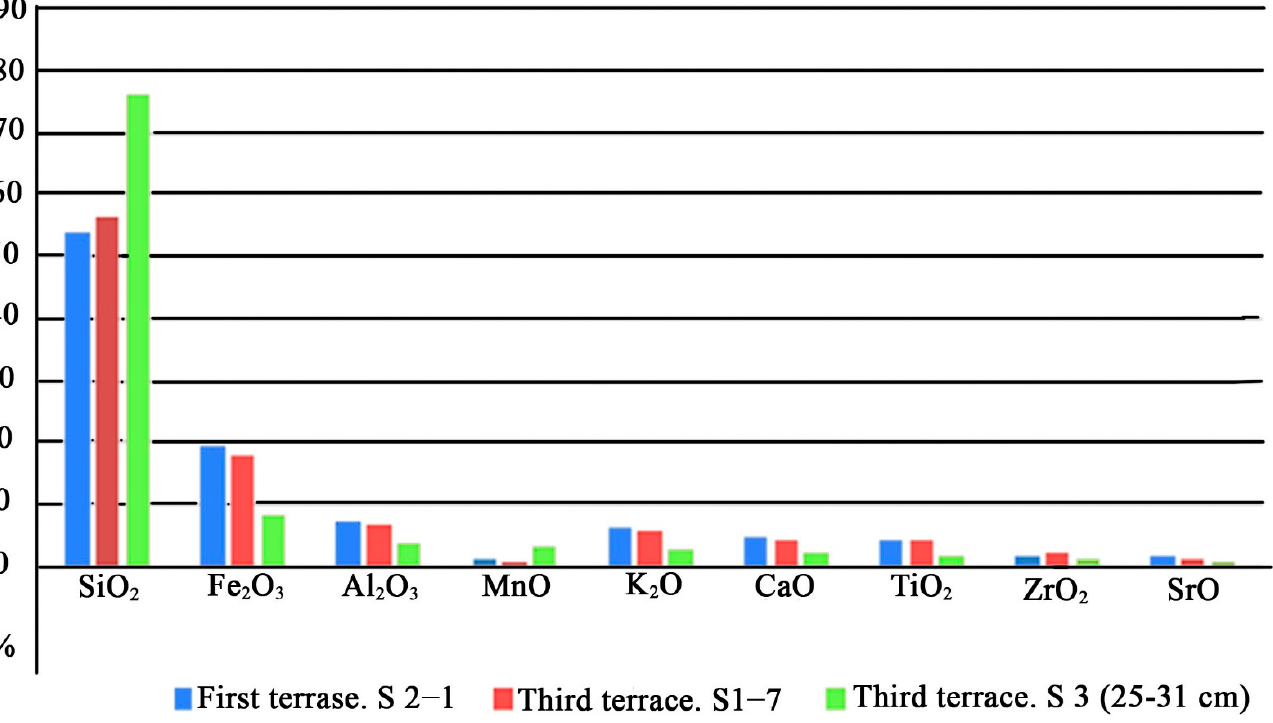
Figure 3. The distribution of chemical elements in studied soils from different landscape positions.